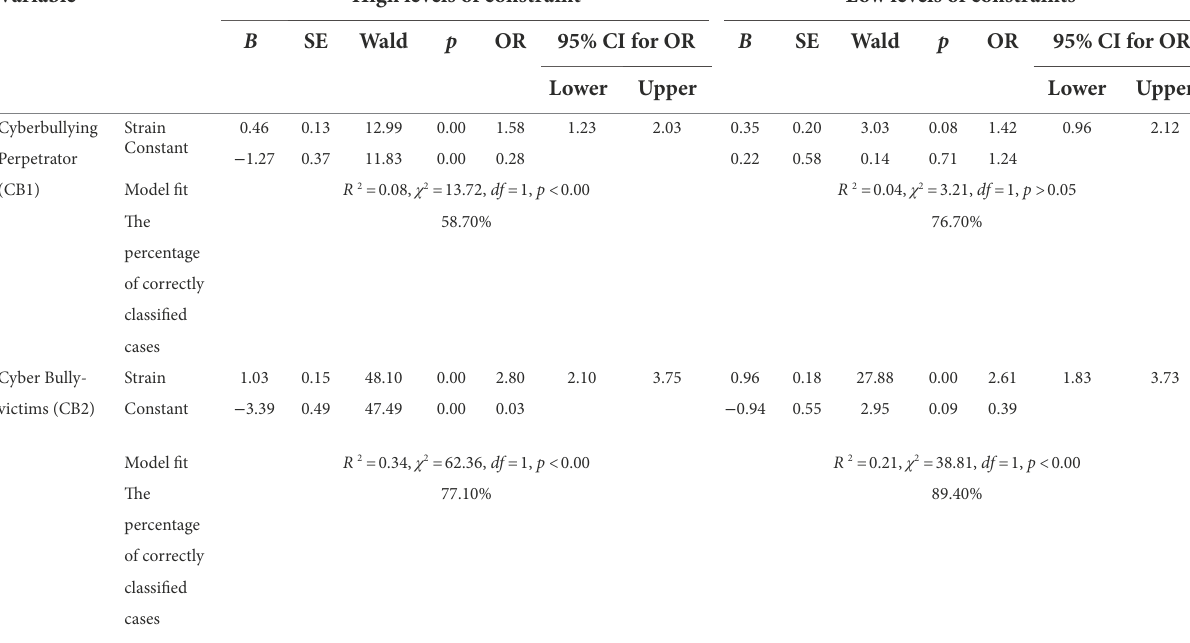
TABLE 4 Results of the binary logistic regression analysis of constraints, strain, and cyberbullying. Variable